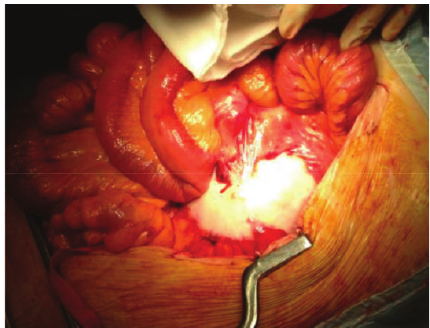
Figure 2: Intraoperative picture showing the thickened aortic wall and perianeurysmal fibrosis with significant adhesions to the surrounding structures encountered during the attempt of open